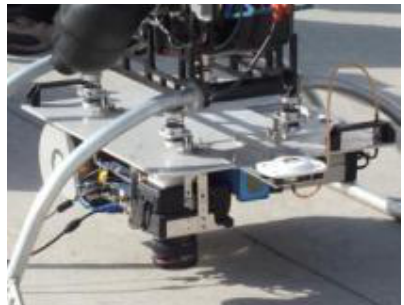
Figure 1 Damping parts of Lidar on a 100kg gasoline helicopter